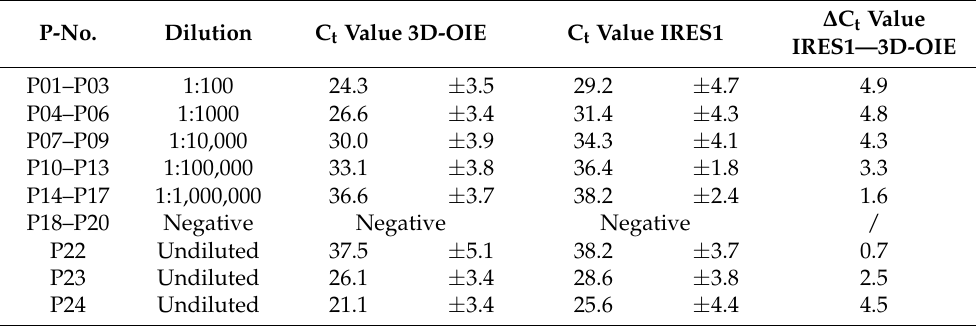
Table 3. Overview of the PCR results. Indicated for each sample group are the mean value and the twofold standard deviation of the results submitted by all